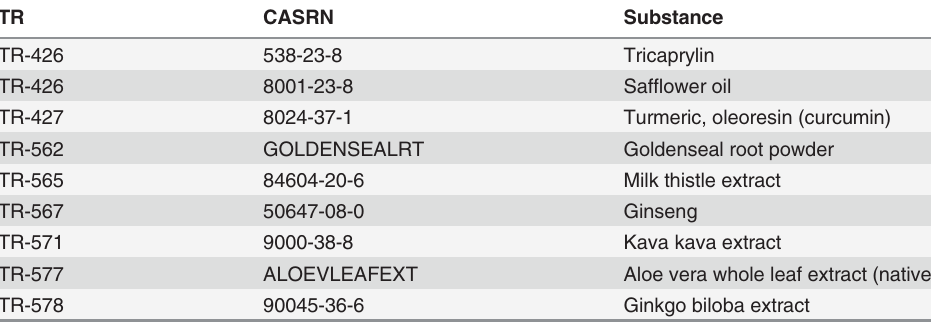
Table 3. List of 2Y-CSs on multi-compounds that were included in the analysis. TR CASRN Substance TR-426 538-23-8 Tricaprylin TR-426 8001-23-8 Saf fl ower oil TR-427 8024-37-1 Turmeric, oleoresin (curcumin) TR-562 GOLDENSEALRT Goldenseal root powder TR-565 84604-20-6 Milk thistle extract TR-567 50647-08-0 TR-571 TR-577 ALOEVLEAFEXT Aloe vera whole leaf extract (native) TR-578 90045-36-6 Ginkgo biloba extract The left column shows the name of all Technical Reports (TR) that were included in the analysis. The middle column shows the Chemical Abstracts Service Registry Number (CASRN) of the test substance, as termed in the CarTox database. The right column shows the name of the test substance, as termed in the CarTox